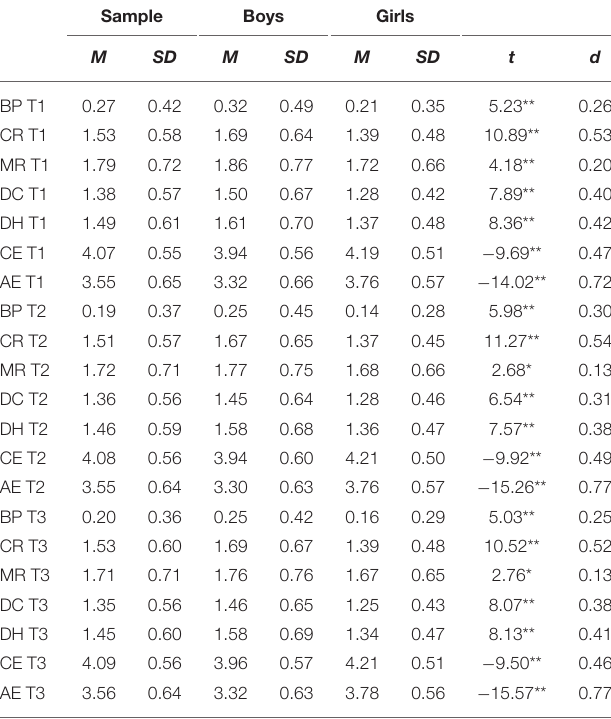
TABLE 1 | Means, standard deviations and differences by gender for all variables.